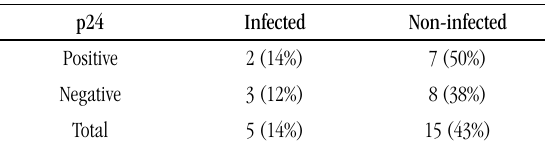
tABLE 1 – Correlation between p24 viral rotein and vertical transmission